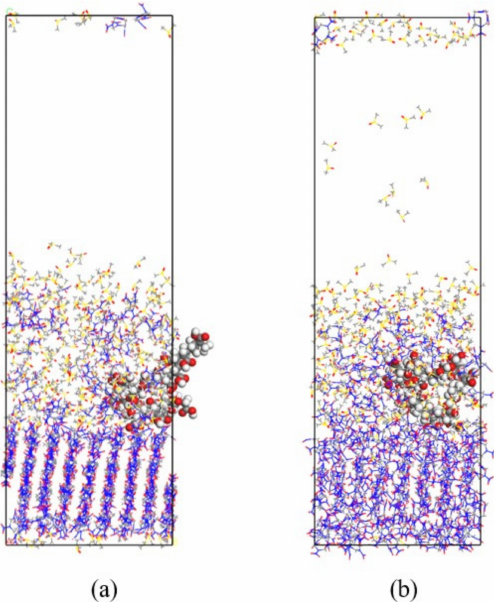
Figure 13. The dynamic equilibrium trajectory of the crystallization system at 400 ps at different temperatures. ( a ) 357 K and ( b ) 378